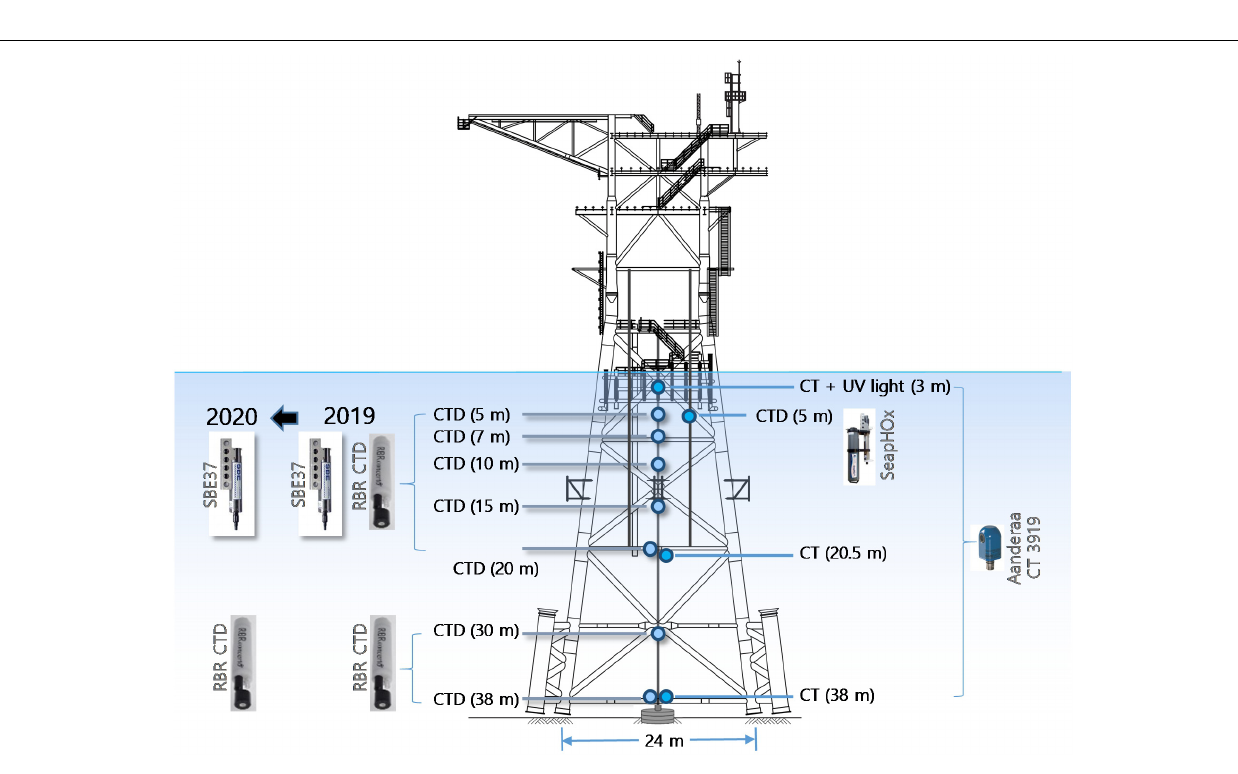
Frontiers in Marine Science |